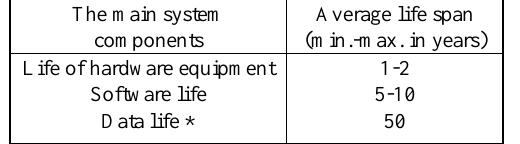
Table 3. Average life span of system components. (Köktürk, E. and Köktürk, E. 2002).